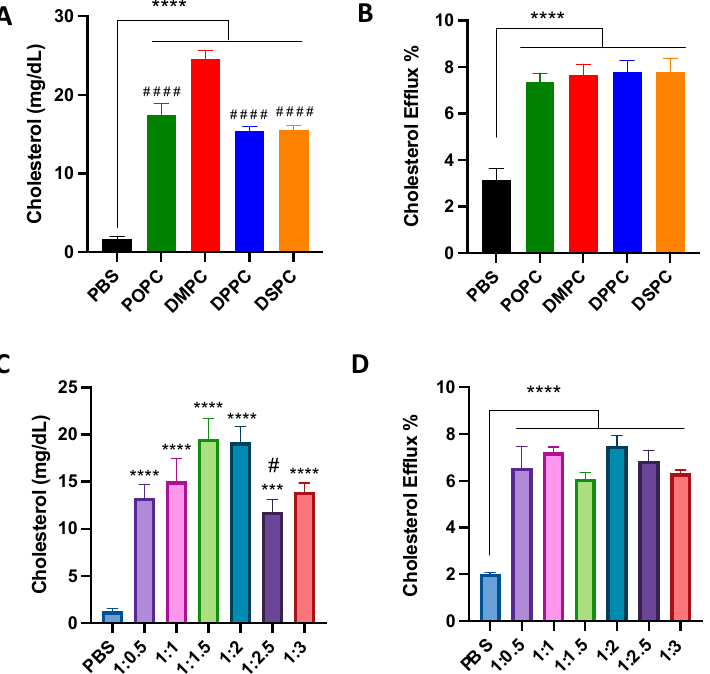
Figure 2. Cholesterol crystal dissolution after 7 days of incubation with different PC lipids ( A ) and different ratios of DMPC:DSPE-PEG2k ( C ). Effect of 4 h incubation of different PC lipids ( B ) and different ratios of DMPC:DSPE-PEG2k ( D ) on the cholesterol efflux of J774A.1 macrophage cells containing radiolabeled cholesterol. *** p < 0.001, **** p < 0.0001 when compared to untreated PBS group. ( n = 3, mean ± SD. # p < 0.05, #### p < 0.0001 when compared to DMPC or 1:2 group).